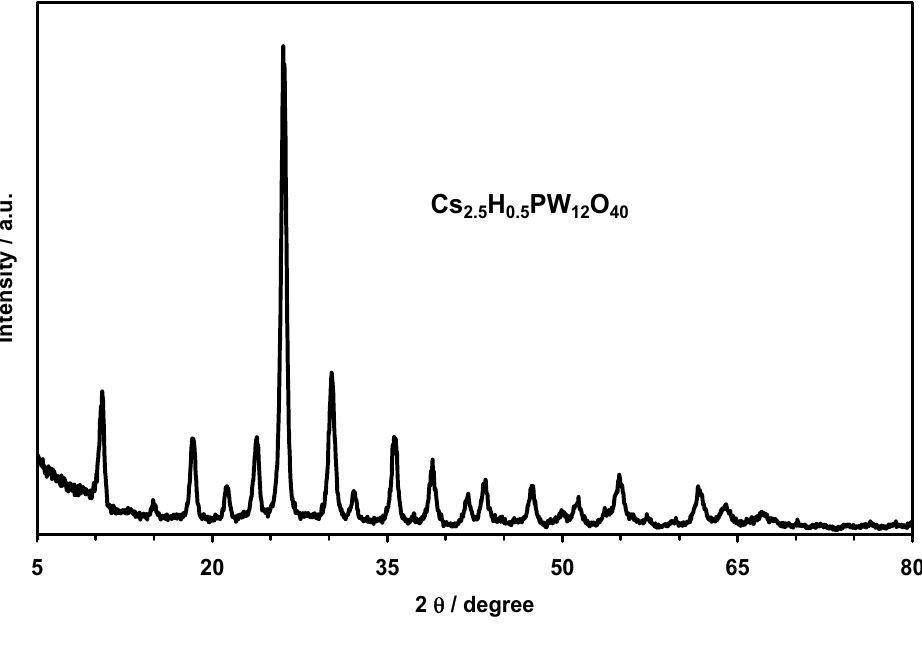
Figure 1. X-ray diffraction of the promoter